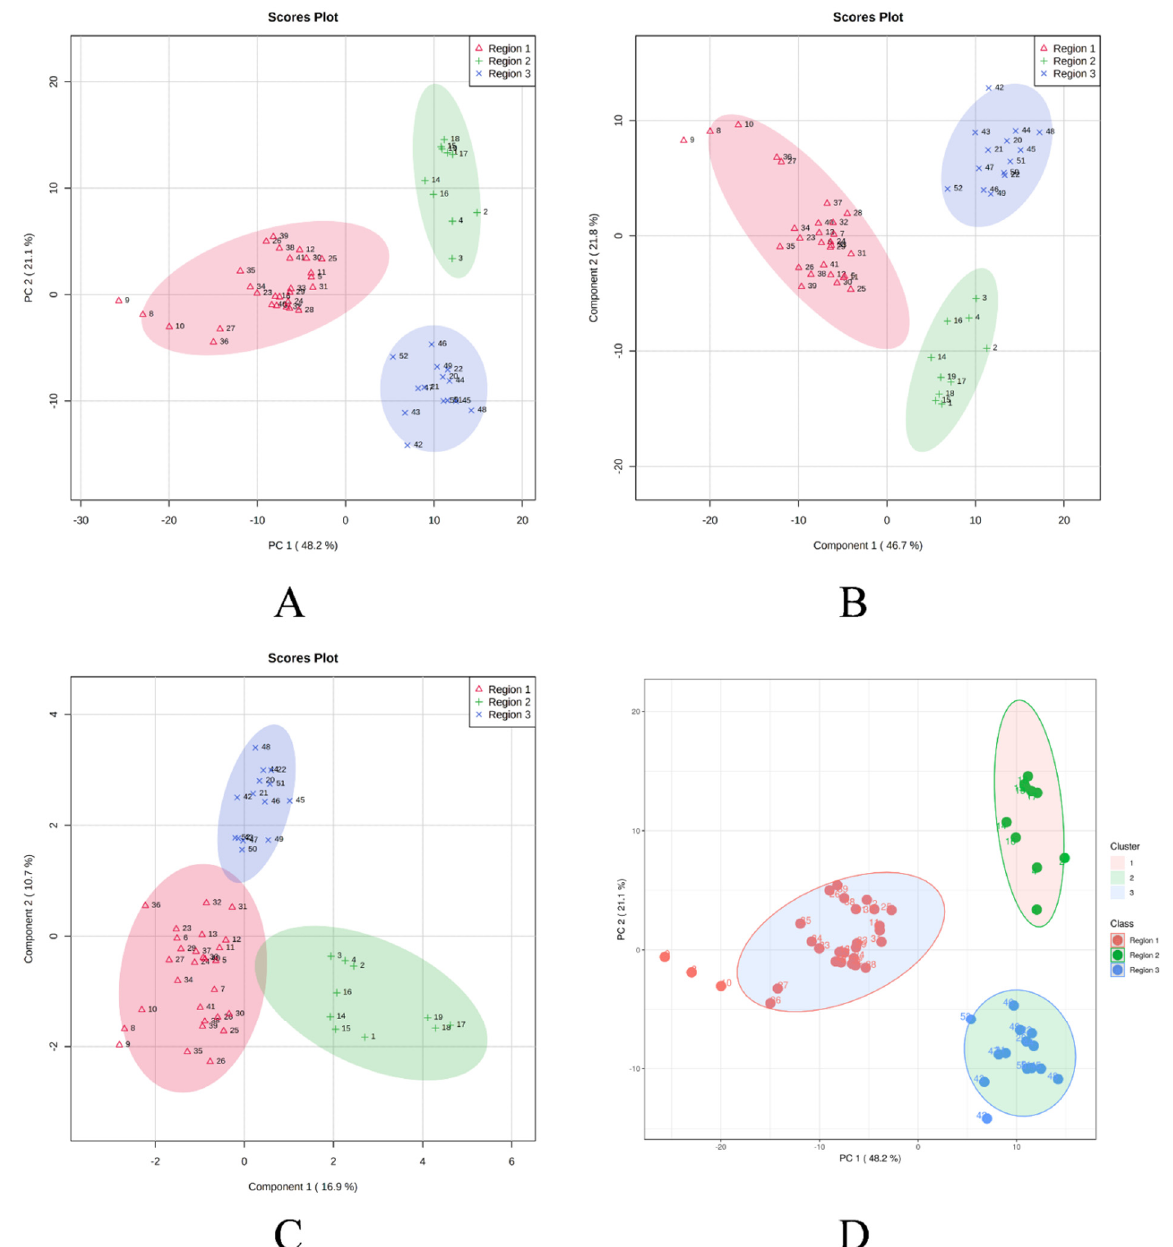
Figure 4. Score plot generated between the selected PCs with their variances. ( A ) PCA; ( B ) PLS-DA; ( C ) sPLS-DA; ( D ) K-means clustering.